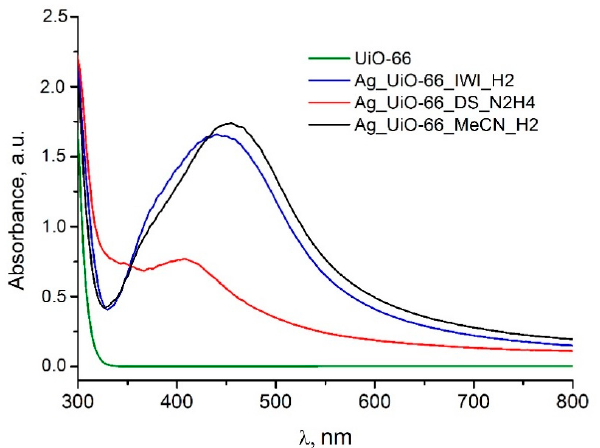
Figure 2. UV-Vis DR spectra of UiO-66 (green) and Ag@UiO-66 prepared by IWI_H 2 (blue), MeCN_H 2 (black), and DS_N 2 H 4 (red).